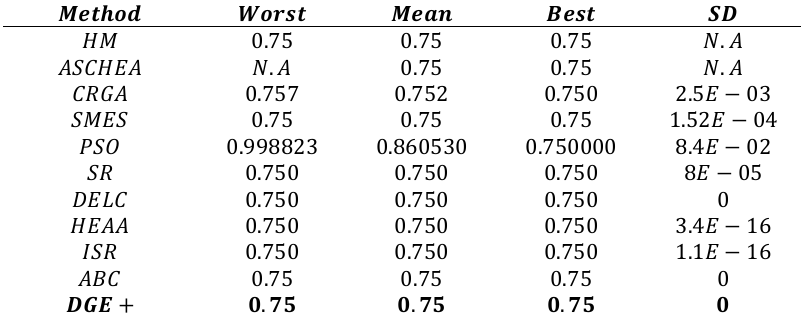
Table 4. Statistical comparison of results for constrained problem 2 of various algorithms